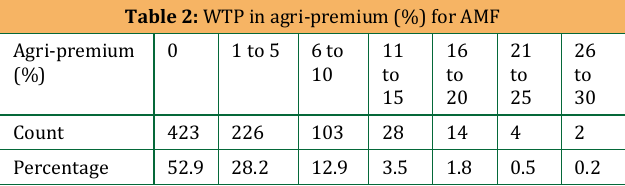
Table 2: WTP in agri-premium (%) for AMF